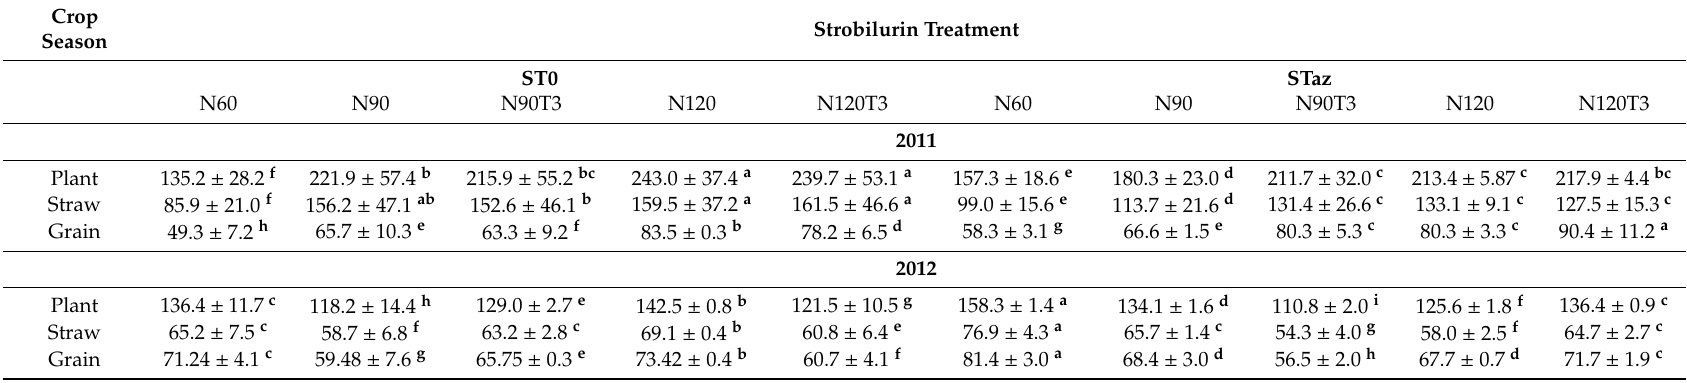
Table 5. E ff ect of the interactions between nitrogen fertilization and strobilurin treatment in 2011 and 2012 for plant, straw and grain N content (kg kg − 1 ). Crop